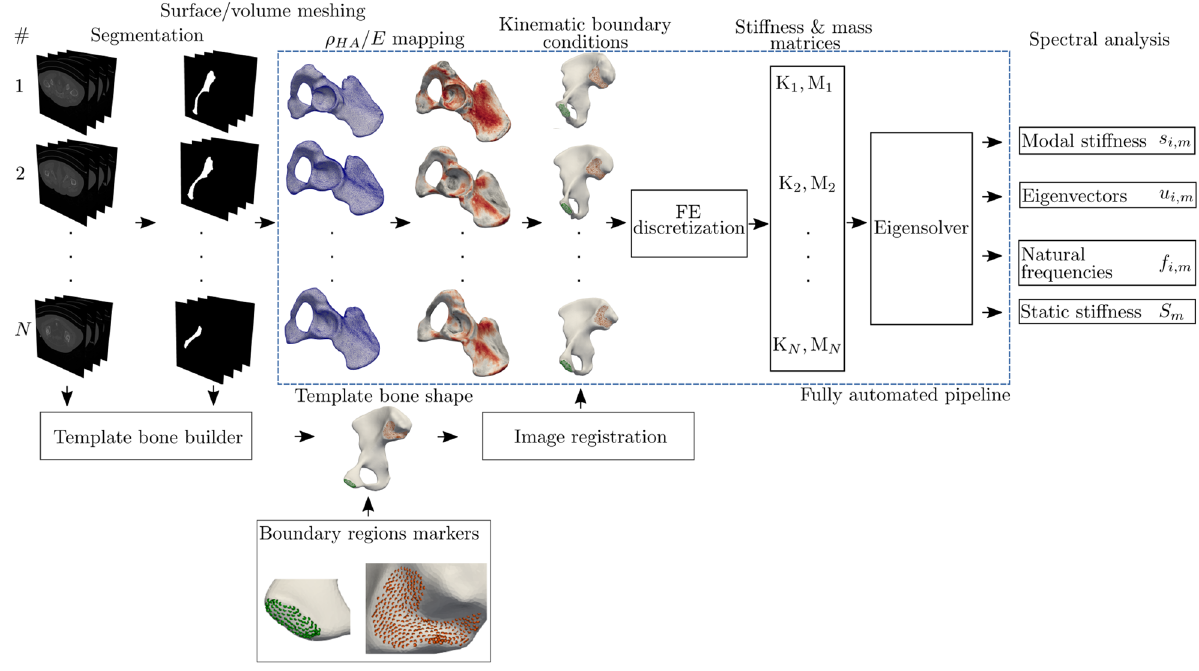
Figure 6. A pipeline of building the FE model based on the CT data. The boundary points(green/orange) are used to apply the kinematic boundary